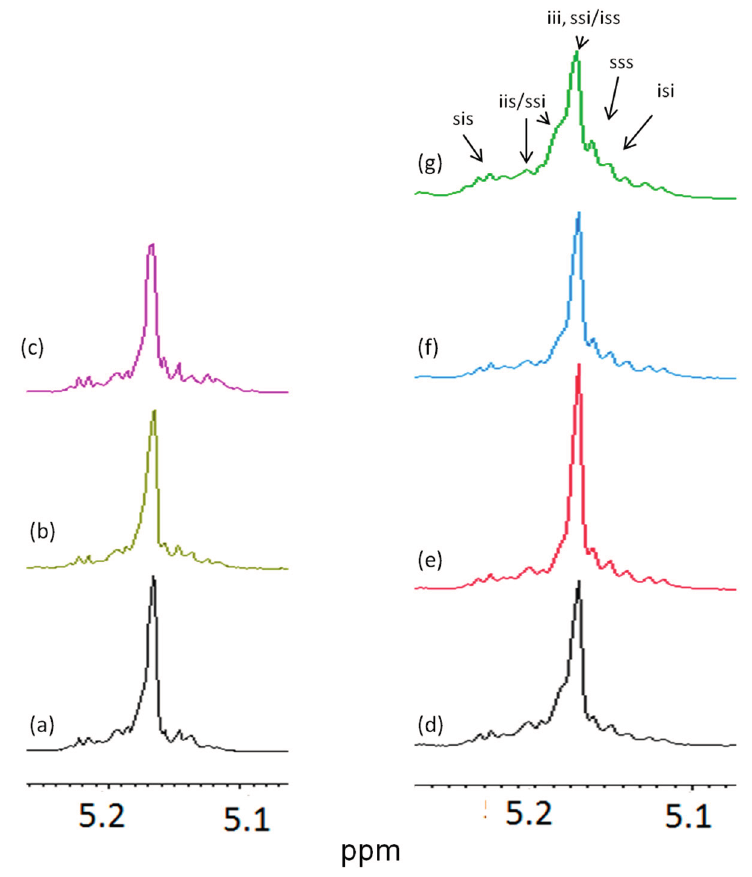
Figure 4. Methine proton signals from the homonuclear-decouple 1 H-NMR spectra of (a) LE(m)-1.35, (b) LE(m)-1.53, (c) LE(m)-2.27, (d) LE(m)-1.38, (e) LE(m)-2.78, (f) LE(m)-2.75 and (g) LE(m)-2.93 (i, isotactic; s,